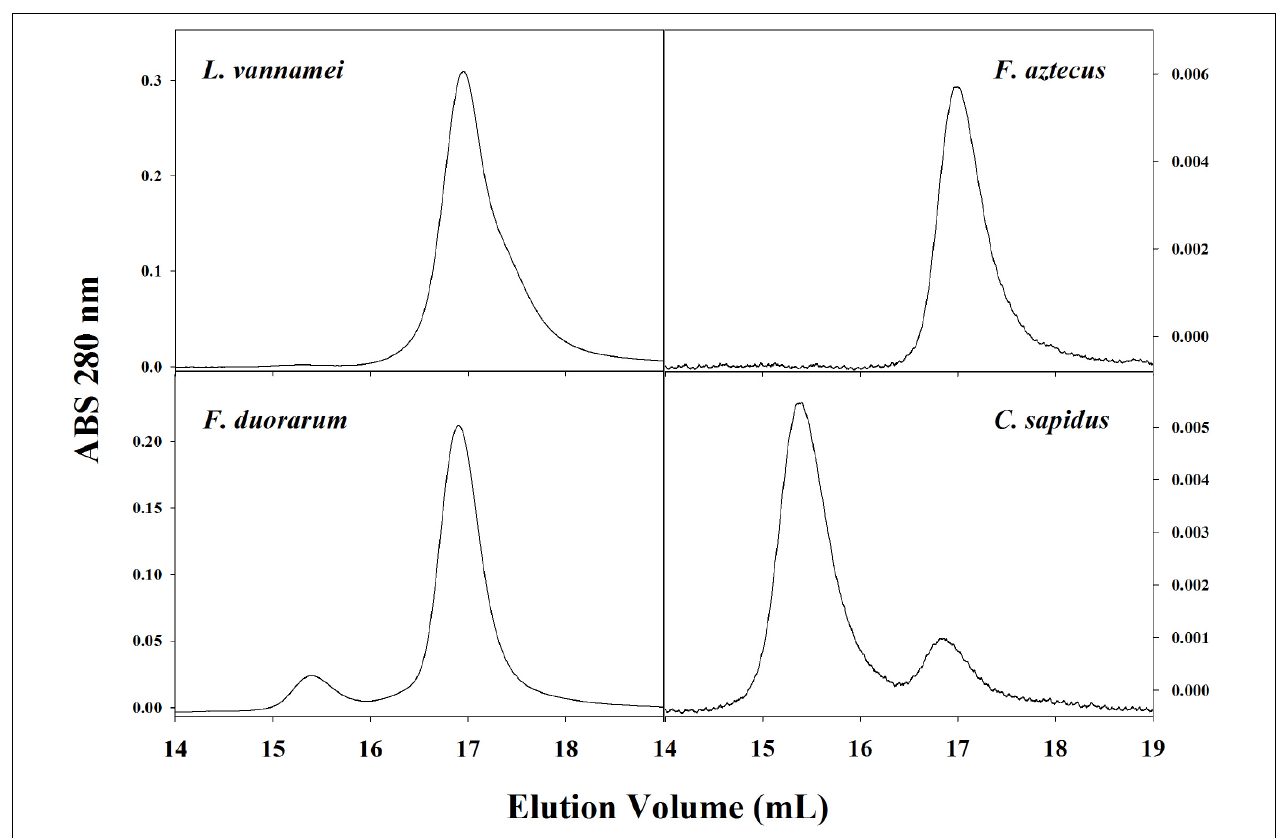
FIGURE 5 | Representative SE-HPLC (2x BioSep SEC-400-5 in series) chromatograms (OD 280 ) of four crustacean species show different usage of hemocyanin oligomers in hemolymph. The dodecameric hemocyanin appears between 15 and 16 mL elution volume and the hexamer appears at approximately 17 mL elution